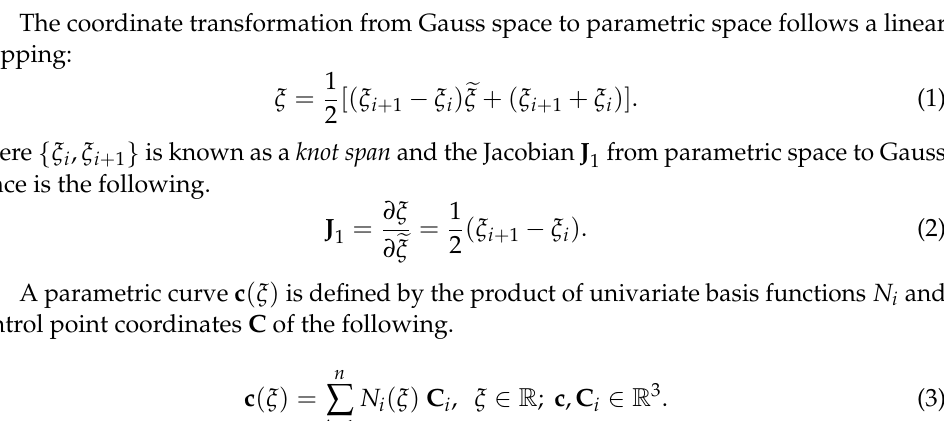
Figure 2. Coordinate systems and mappings.